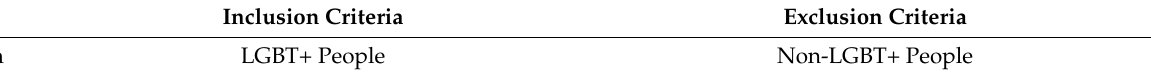
Table 3. Inclusion and exclusion